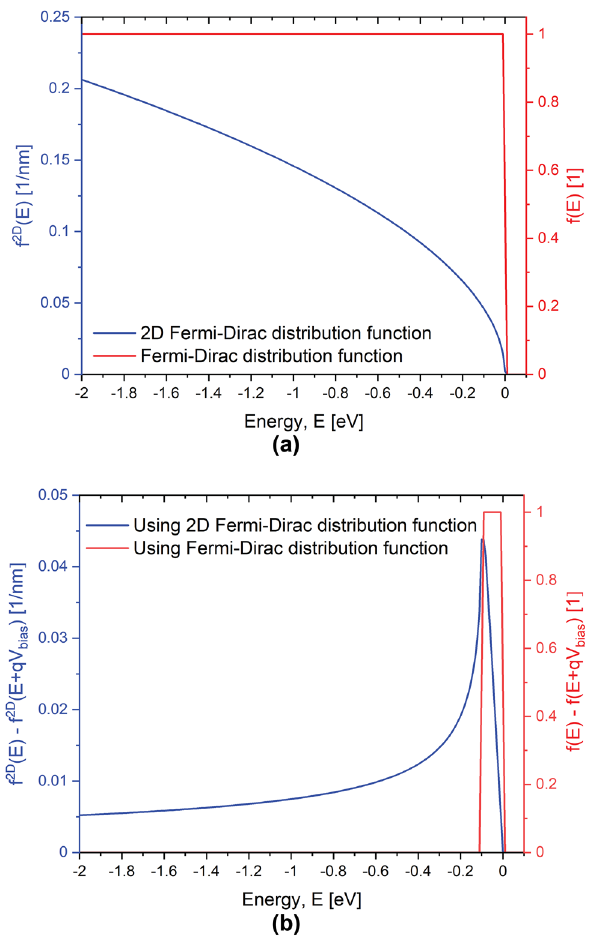
Figure 11. Fermi–Dirac distribution functions. ( a ) Comparison between the Fermi-Dirac distribution function, Eq. (40), and the effective 2D Fermi-Dirac distribution function, Eq. (43), for equilibrium conditions 4.0 K. ( b ) Comparison between the Fermi-Dirac function difference between source and drain, and T = f s ( E ) f d ( E ) f ( E ) f ( E qV bias ) , and the corresponding effective 2D Fermi-Dirac distribution function, − = − + f 2